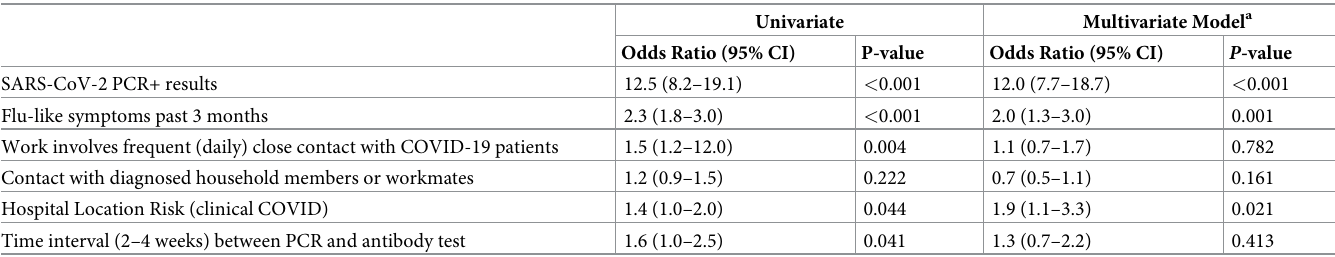
Table 4. Predictors of a positive anti-nucleocapsid IgG result.